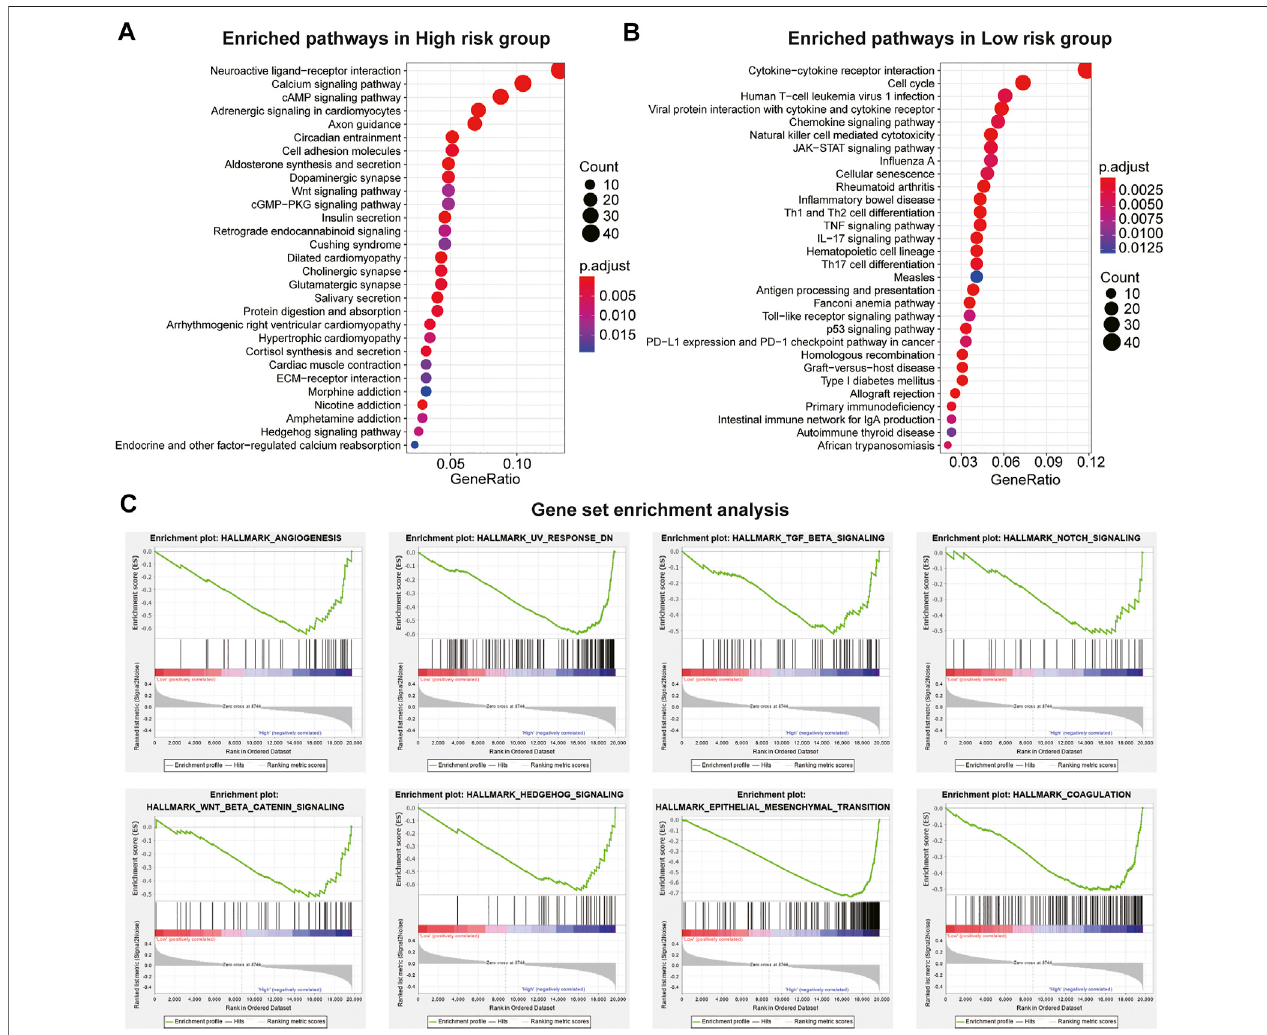
FIGURE5| Pathwayandhallmarksassociatedwiththeimmuneevasion-relatedgenessignature. (A) top30enrichedKyotoEncyclopediaofGenesandGenomes (KEGG) pathways in high-risk CC subgroup vs. low-risk subgroup in the Cancer Genome Atlas (TCGA) cohort. (B) top 30 enriched KEGG pathways in low-risk CC subgroup vs. high-risk subgroup in the GSE39582 cohort. (C) signi fi cantly enriched hallmarks in high-risk subgroup CC patients using the GSEA method in the TCGA cohort.